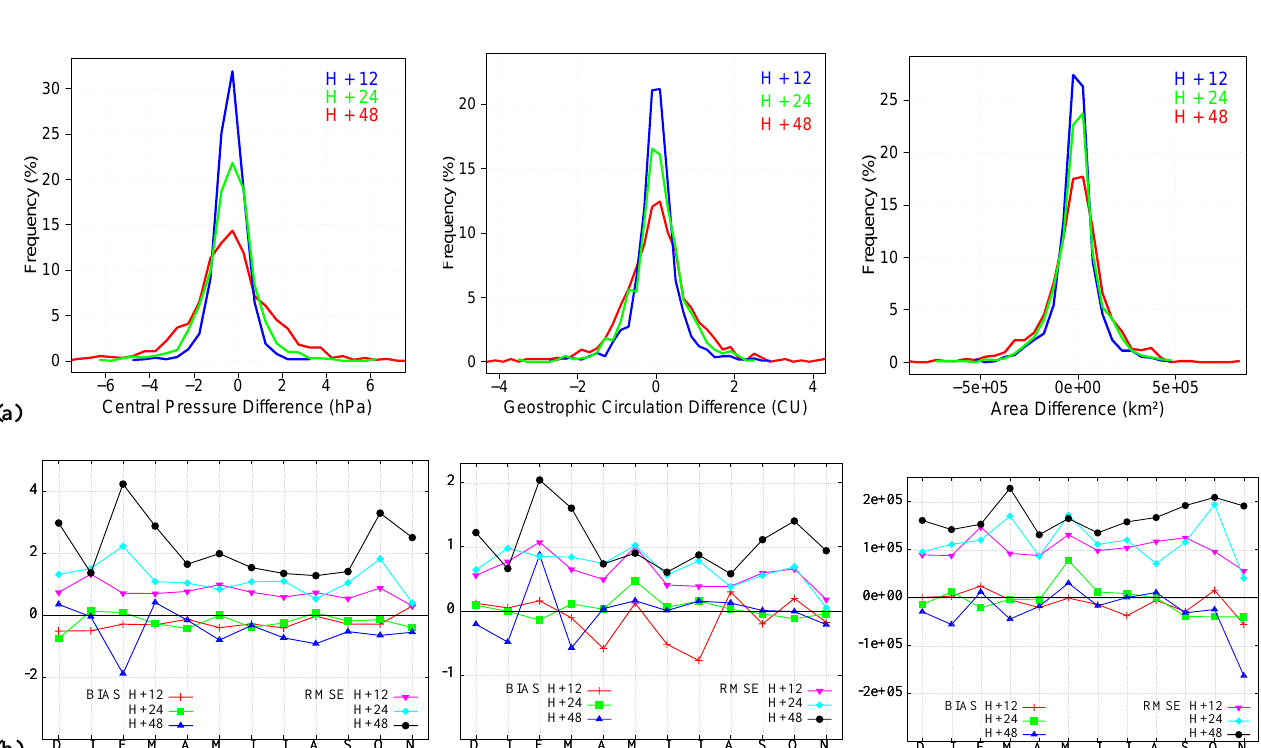
Fig. 3. (a) Frequency distribution (%) of the differences in central pressure (hPa), geostrophic circulation (CU), area (km 2 ), and (b) bias and RMSE for these differences H+12, H+24, and H+48 for each